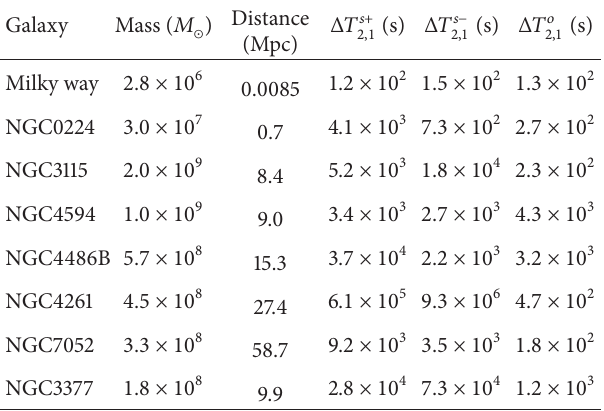
Table 9: Estimation of time delays of the supermassive BHs located at the center of galaxies for phantom global monopole ( 𝜉 = −1 ) with 𝜂 = 0.2 . Galaxy